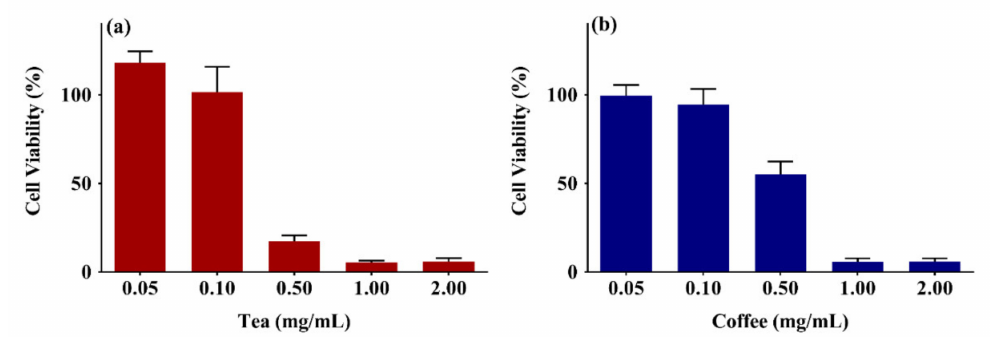
Figure 2. Cell viability study of ( a ) black tea extract, ( b ) coffee extracts on HaCaT cells using MTT assay. The results from three independent experiments (3 replicates in each experiment) are presented as mean ± standard deviation